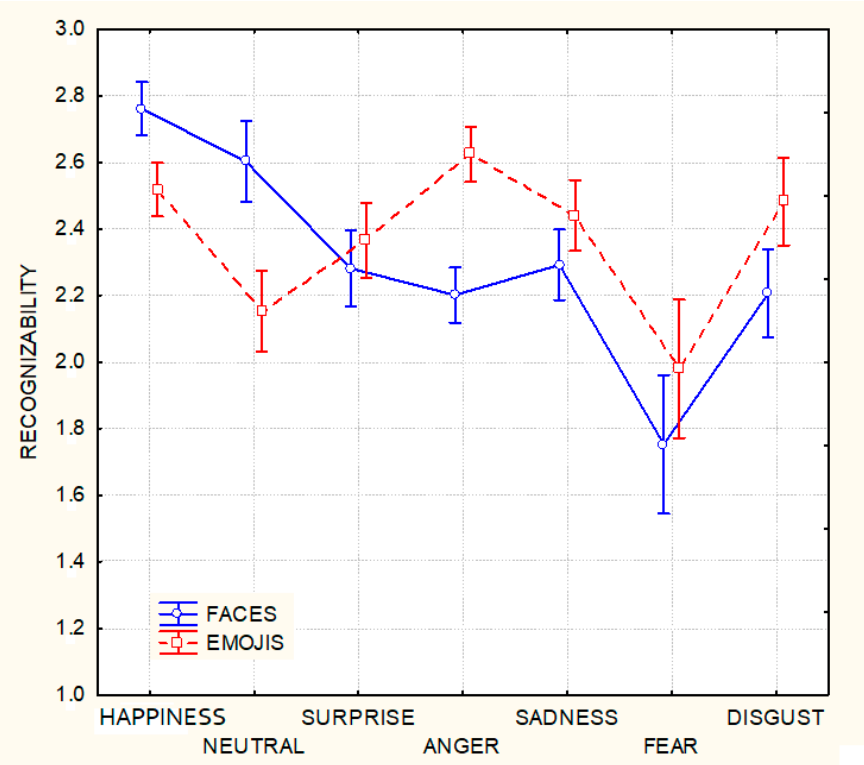
Figure 2. Mean recognizability scores (with standard deviations) relative to the 7 expressions illustrated by human faces and emoji.